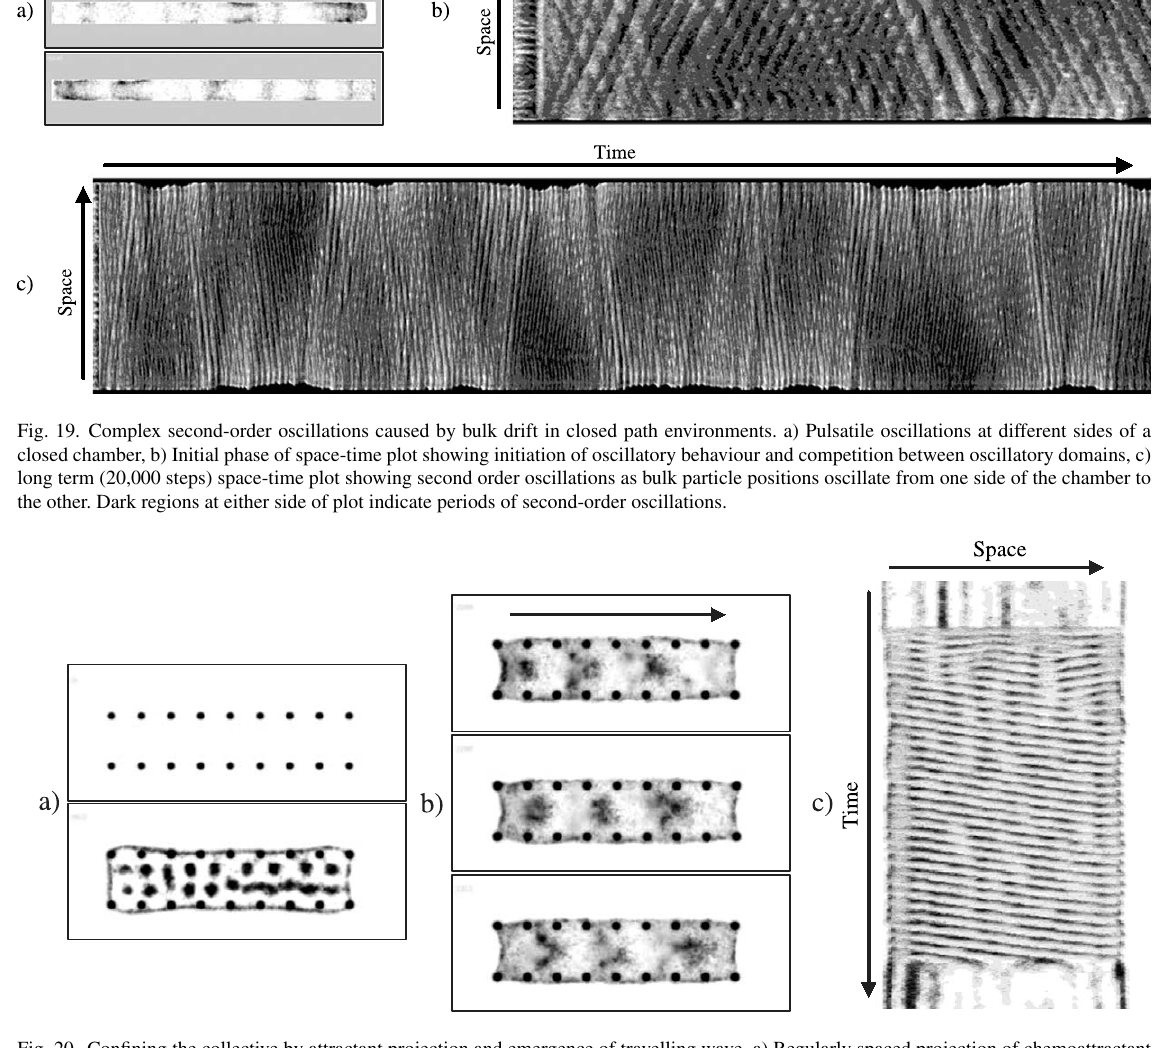
Fig. 20. Confining the collective by attractant projection and emergence of travelling wave. a) Regularly spaced projection of chemoattractant sources (top) confines position of collective (bottom), b) When oscillatory motor behaviour is activated a travelling wave emerges across the confined collective, c) Space-time plot of the emergence of travelling waves in a pinned